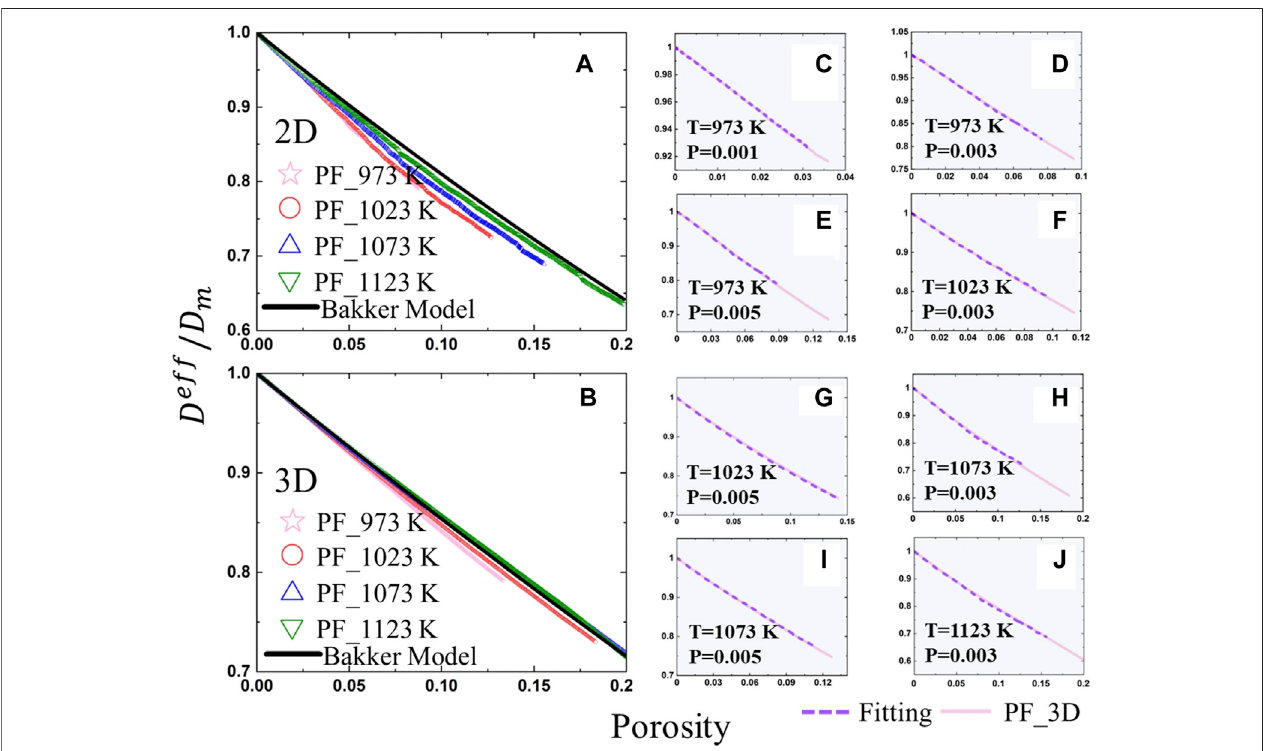
FIGURE 6 | The simulated and analytical effective diffusion coef fi cients as a function of the porosity for four different temperatures in 2D (A) and 3D (B) . (C) – (J) Comparison between the simulated and fi tted effective diffusion coef fi cients of H in 3D porous W as a function of the temperature and porosity, in which the pink solid curves represent the simulation results and the purple dotted curves represent the results predicted by Eq. 39 based on 2D results.